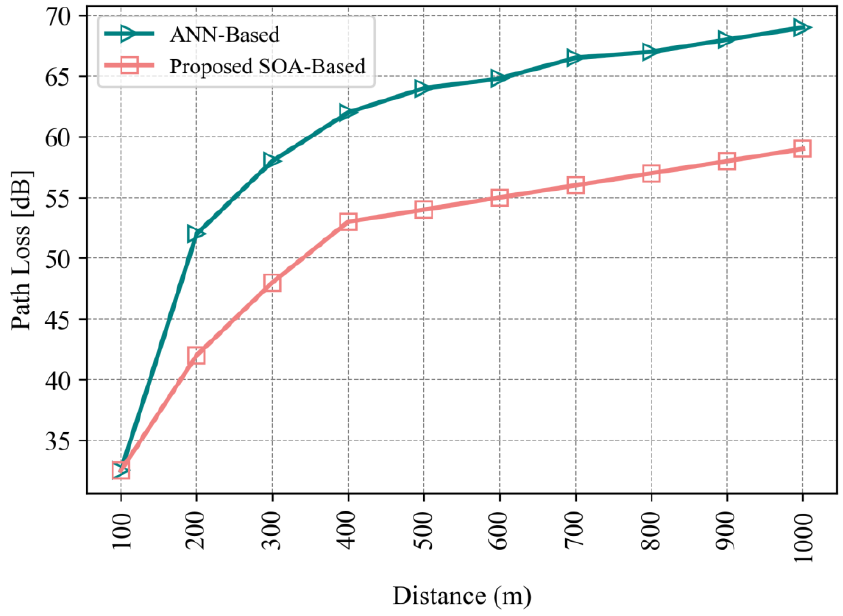
Figure 11. Comparative analysis of path loss.